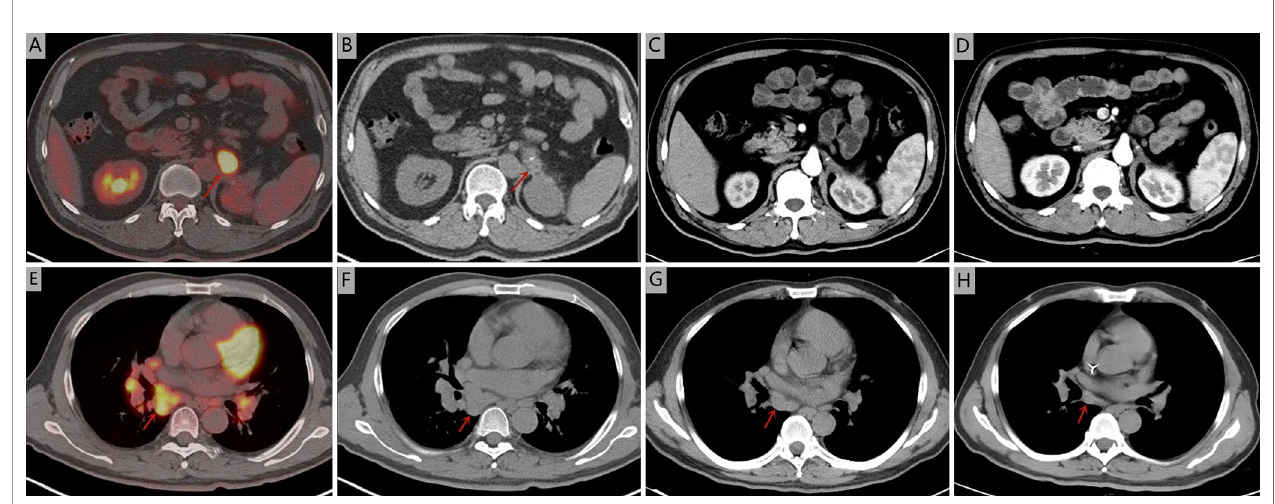
FIGURE 2 | Seven months after operation, positron emission tomography/computed tomography was performed. (A, B) The soft tissue mass in the operative area was accompanied by an abnormal increase of fl uorodeoxyglucose metabolism (maximum standardized uptake value, 21.0). (E, F) The larger lymph nodes were located in the 8R area (4.2× 1.9 cm, maximum standardized uptake value, 7.9). Computed tomography during treatment showed that the tumour lesions disappeared in the arterial phase and the mediastinal and mediastinal-hilar lymph nodes were signi fi cantly reduced or had disappeared. (C, G) after two cycles of chemotherapy. (D, H) after six cycles of